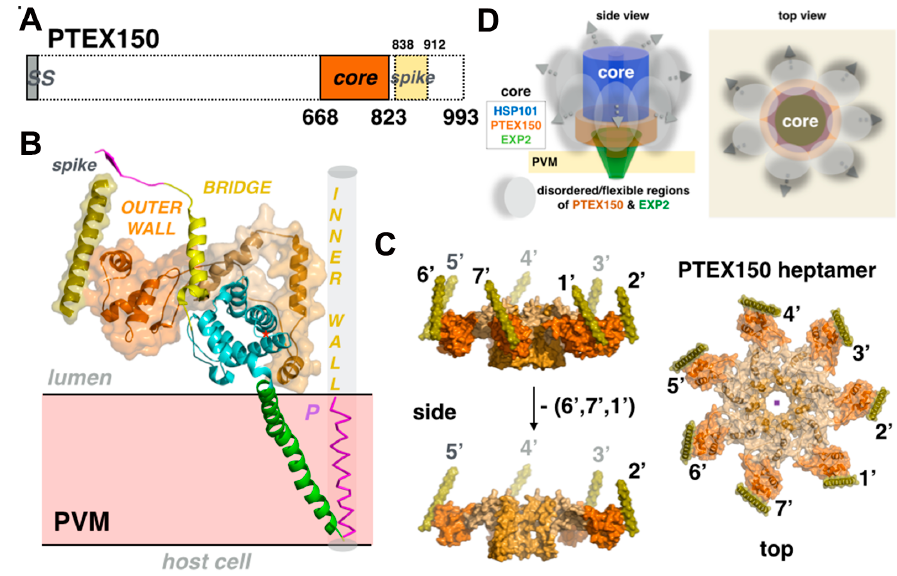
Figure 4. The adaptor protein PTEX150 and disordered regions in Plasmodium proteome. ( A ) Schematic organization of PTEX150, including SS, signal sequence. Only ~18% of the total protein, corresponding to the core and spike domains, are resolved in the structure. ( B ) The PTEX150 protomer structure in transparent surface representation. The core of one PTEX150 protomer can be divided into an outer and inner ‘wall’ separated by a bridge and sits on top of the vestibular domain of the EXP2 protomer (colored as in Figure 3). The hydrophilic inner wall contributes to the lining of the central pore. A model helix (P) indicates the axis of the central pore along the protein-conducting path (transparent grey cylinder). ( C ) Heptameric arrangement of PTEX150. ( D ) Schematic showing the overall contribution of the disordered/flexible protein regions in PTEX.